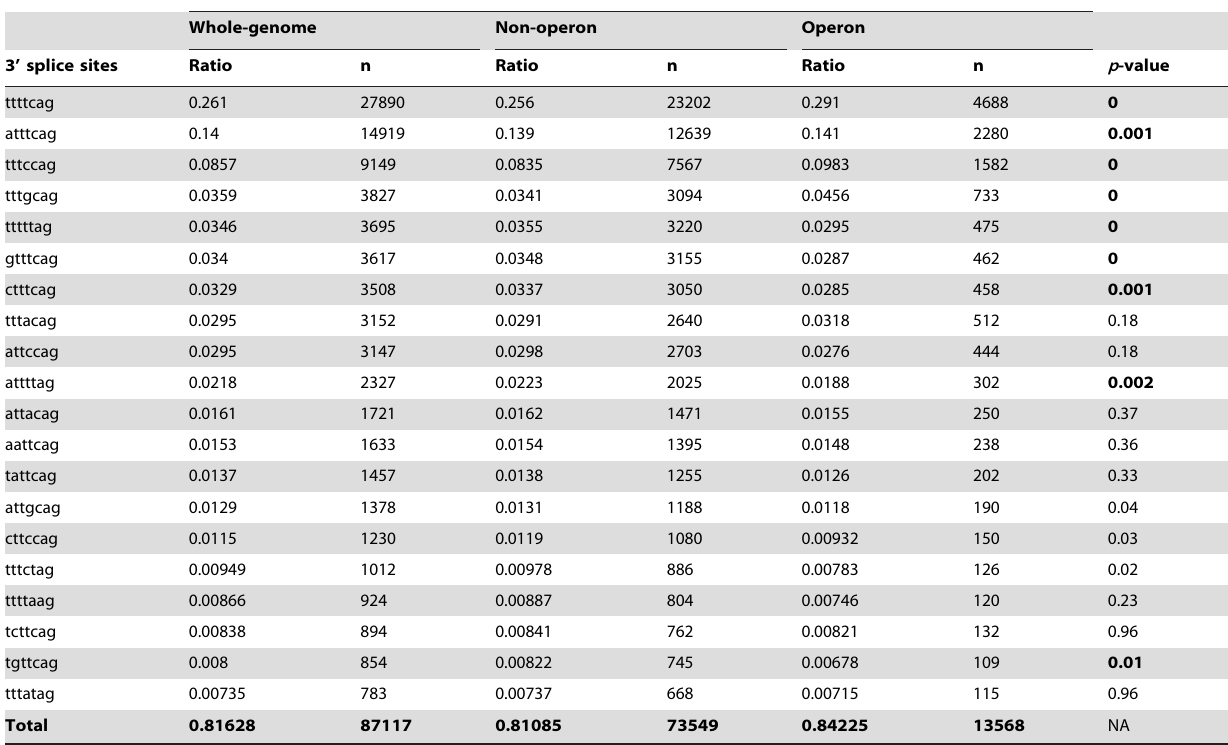
Proportions and numbers of the top 20 3’ splice sites in each group of genes